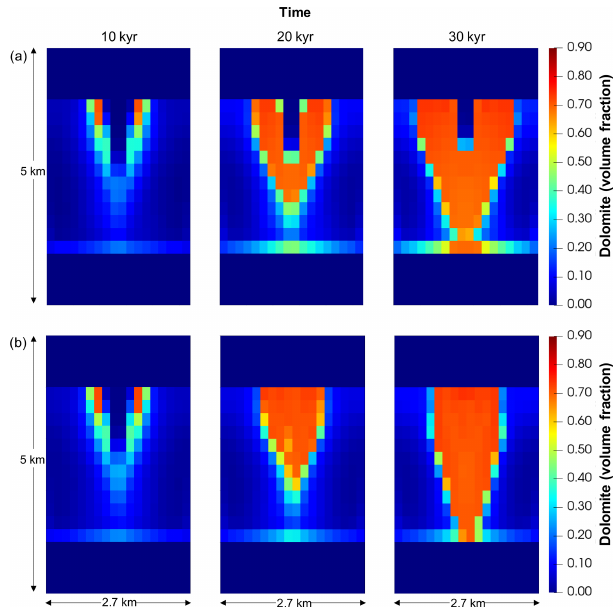
Figure 7. Development of the dolomite geobody within the FDZ cutting along the middle of the fault plane: (a) the 3D simulation with the porosity–permeability feedback turned off, and (b) the baseline 3D simulation that includes feedback between porosity and permeability that results in localised advection of heat from the ma- trix and dolomitisation in the downwelling